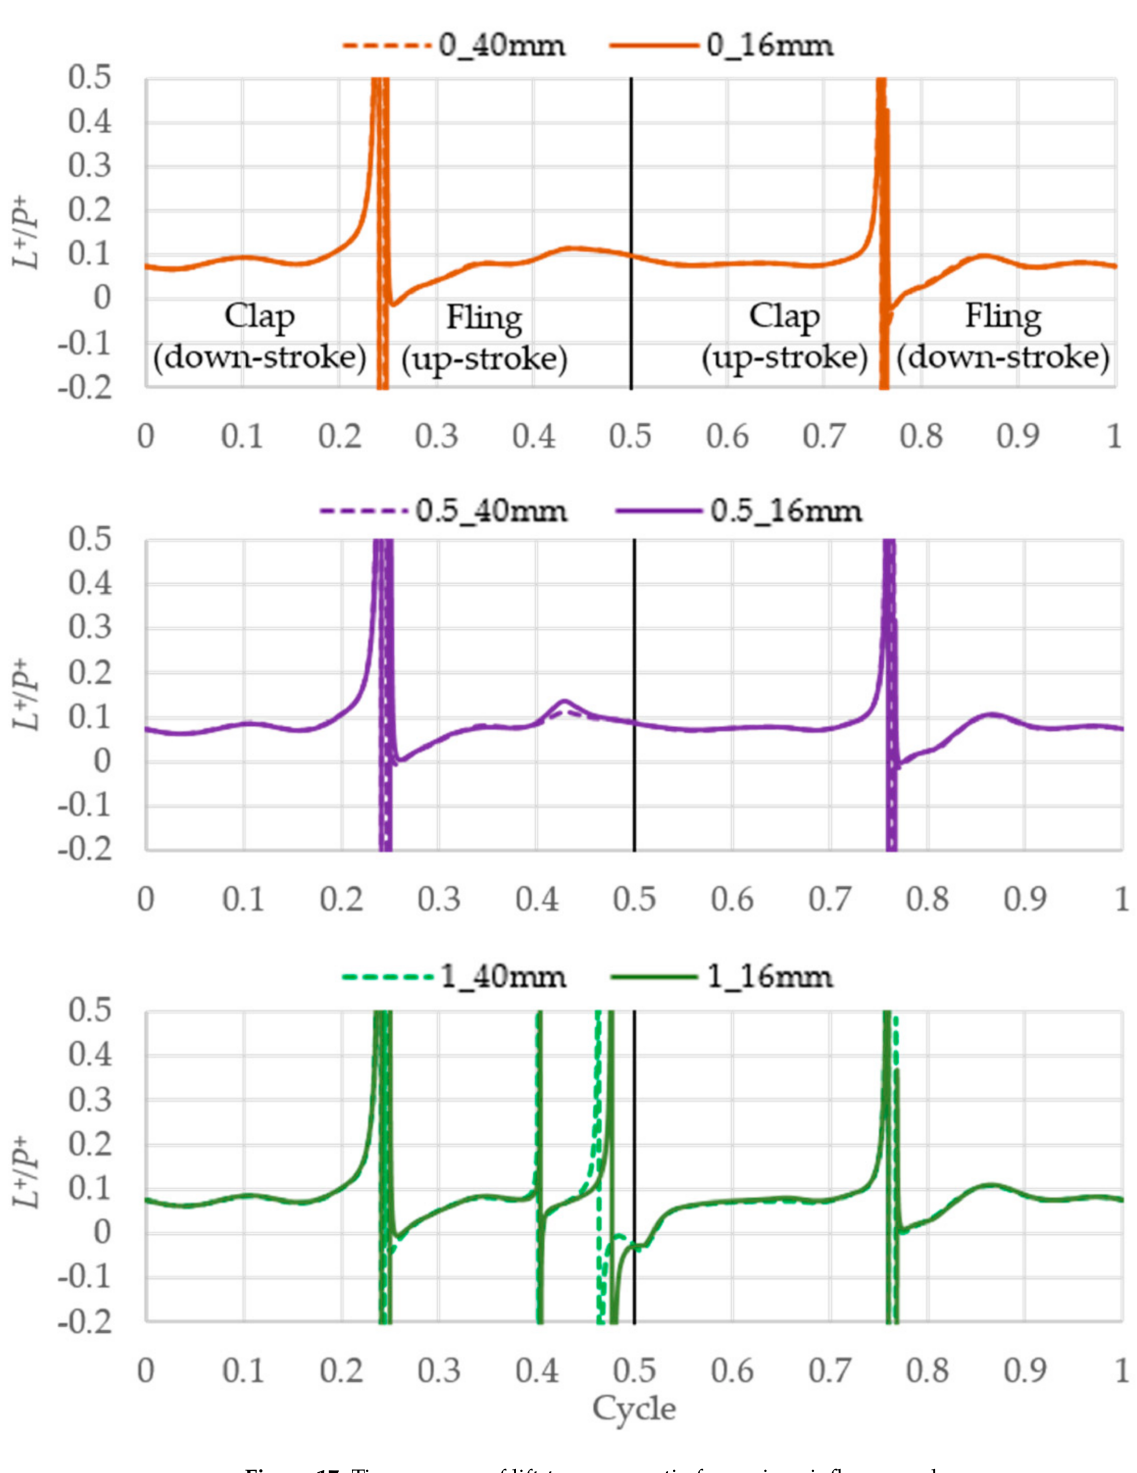
Figure 17. Time courses of lift-to-power ratio for various inflow